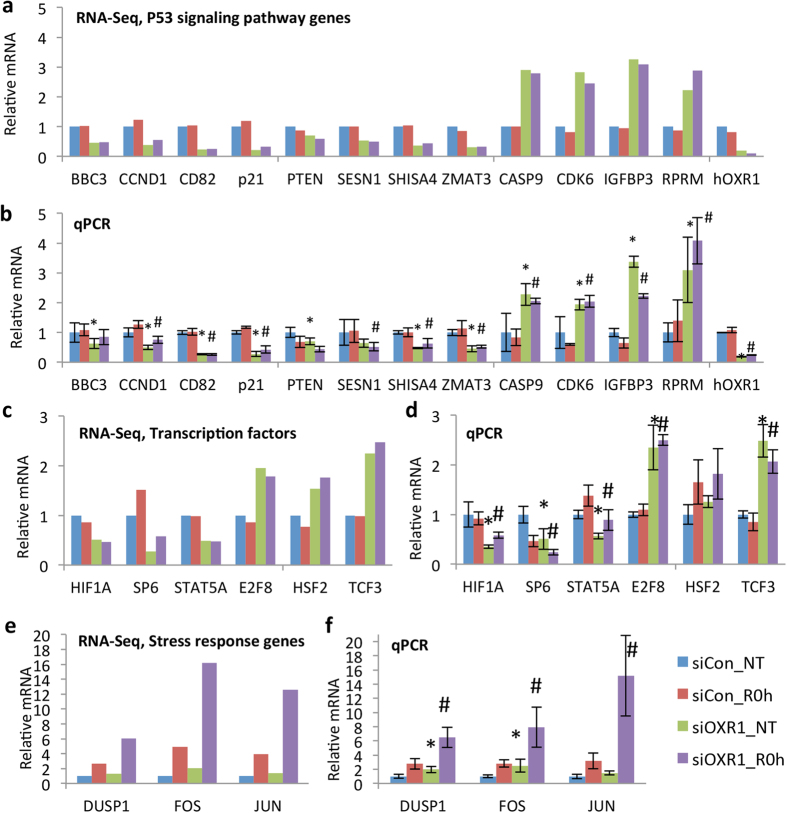
Validation of RNA-seq data by qPCR.(a,b) Genes involved in p53 signaling pathway. (c,d) Transcription factors. (e,f) Early stress response genes. (a,c,e) Data extracted from RNA-seq. (b,d,f) The mRNA levels of the same set of genes were measured by qPCR. The mRNA level was presented as the fold change as compared to non-treated control cells. The standard deviation was calculated from 4 cDNA samples measured in duplicate. siCon: control siRNA; siOXR1: hOXR1 siRNA;. NT: non-treatment; R0h: cells treated with H2O2 0.5 mM for 1 h and harvested immediately without recovery. *p < 0.01 compared to siCon_NT; #p < 0.01 compared to siCon_R0h.